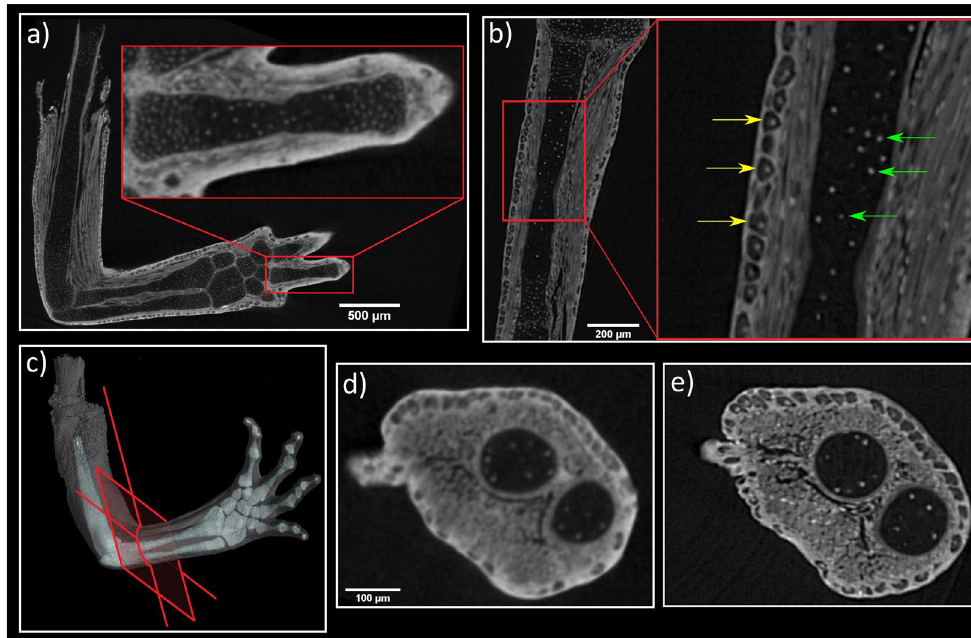
Figure 1. Comparison of the tomographic slices of a P . waltl forearm obtained by conventional and synchrotron µ CT. Despite near-cellular resolution, the employed conventional µ CT setup does not provide sufficient resolution for the automatic counting of cells with necessary accuracy. ( a ) Tomographic slice of the limb, the red area shows detail of one finger, ( b ) reconstructed slice obtained by phase-contrast µ CT at the SYRMEP beamline of the Elettra synchrotron facility, yellow arrows show cells of skin epithelium, green arrows show nuclei of cartilage, ( c ) 3D visualization of a limb with red plane representing the same plane of interest of tomographic slices: ( d ) Data obtained by conventional µ CT and ( e ) by synchrotron µ